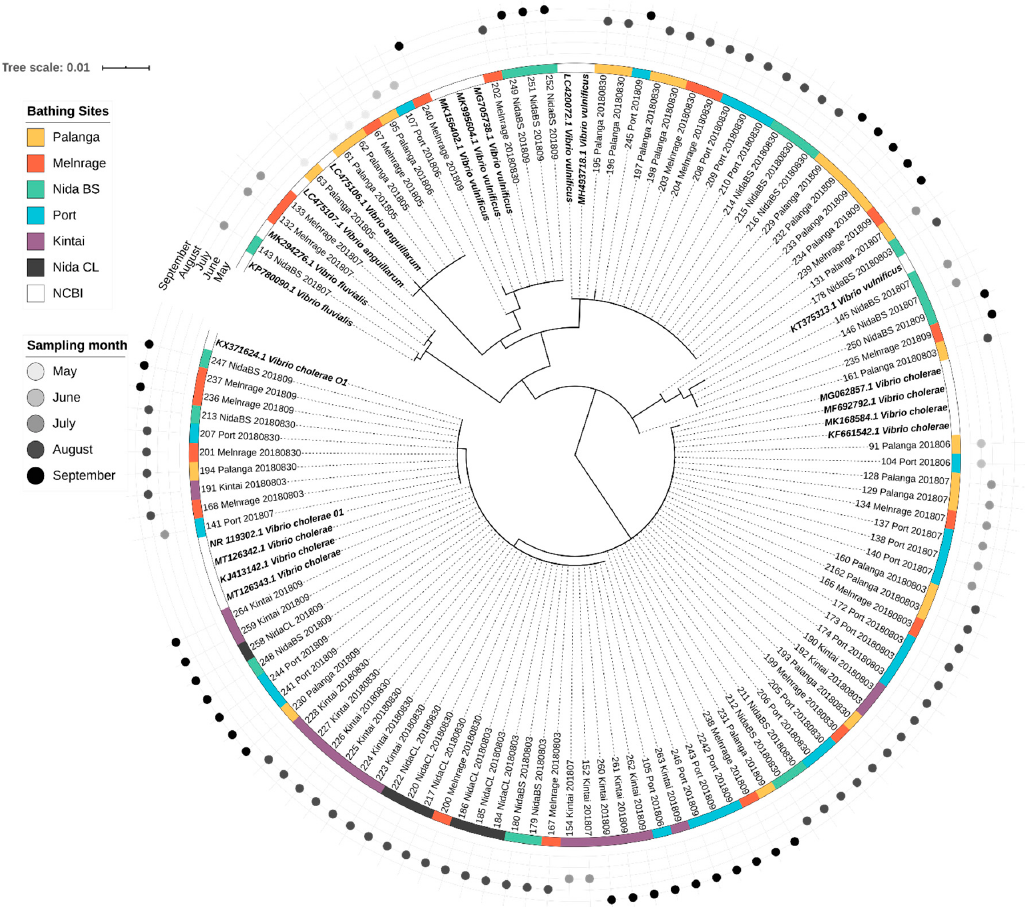
Figure 5. Phylogenetic tree of members of the genus Vibrio based on 16S rRNA sequences. Strains indicated in bold are from the National Center for Biotechnology Information (NCBI) database.